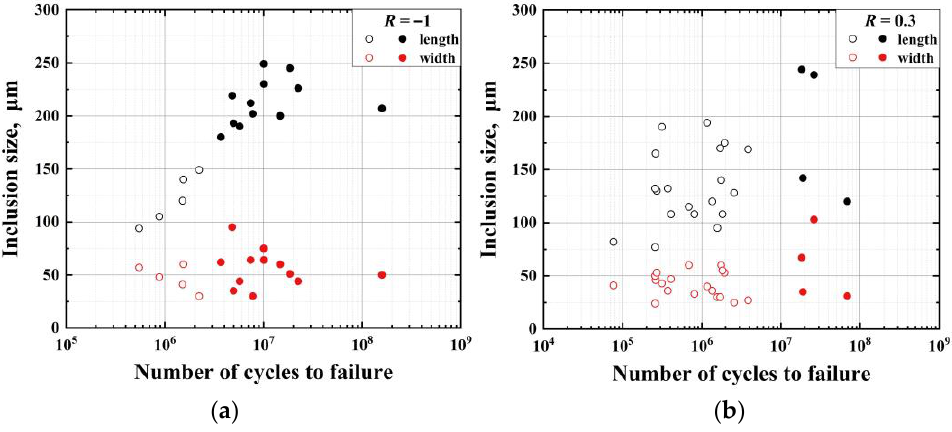
Figure 11. Relationship between inclusion size and fatigue life at ( a ) R = − 1 and ( b ) R = 0.3. Hollow and solid symbols represent the locations of inclusion-inducing fatigue failure, hollow: surface; solid: interior.